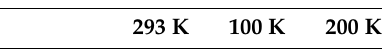
Table 3. Fe-N-C bond angles ( ◦ ) arising from the bent N-bound terminal κ N-ECN coordination mode (E = S ( 1 ), BH 3 ( 2 )).